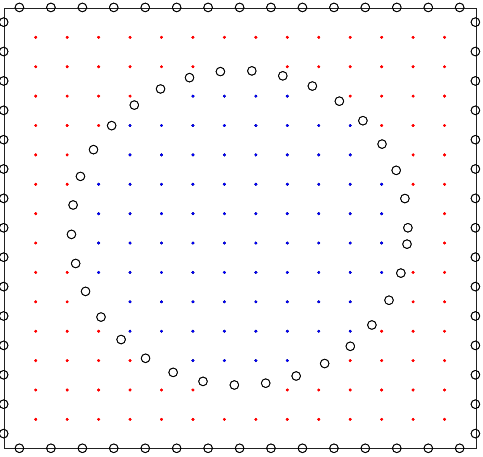
Figure 6. Band structure of the anti-plane transverse wave for aurum/epoxy phononic crystal cal- culated by the LCTM and the FEM (288 elements). Then, the phononic crystal with semi-infinite periodic structure in the y-direction is investigated. The related node distribution is shown in Figure 7. Figure 8 presents the transmission spectra of anti-plane transverse elastic wave along with ΓX - direction. The band structures of the corresponding infinite periodic structure calculated by the pro- posed LCTM are also displayed in this figure. From Figure 8, it can be observed that the proposed LCTM with 1/13 h Δ = ( N = 2729) can perform equally well with the FEM (COMSOL, 6507 elements), which reveals that the developed LCTM can also effectively